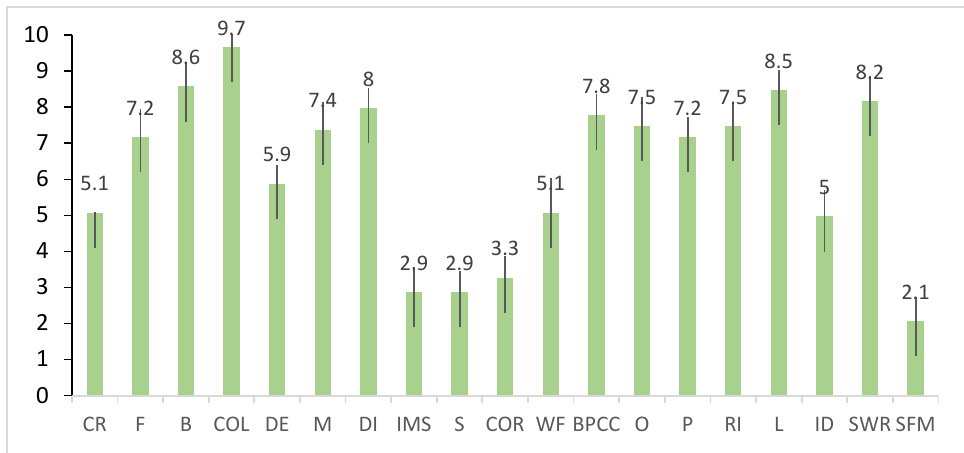
Figure 7. Mean values of 𝑆 .